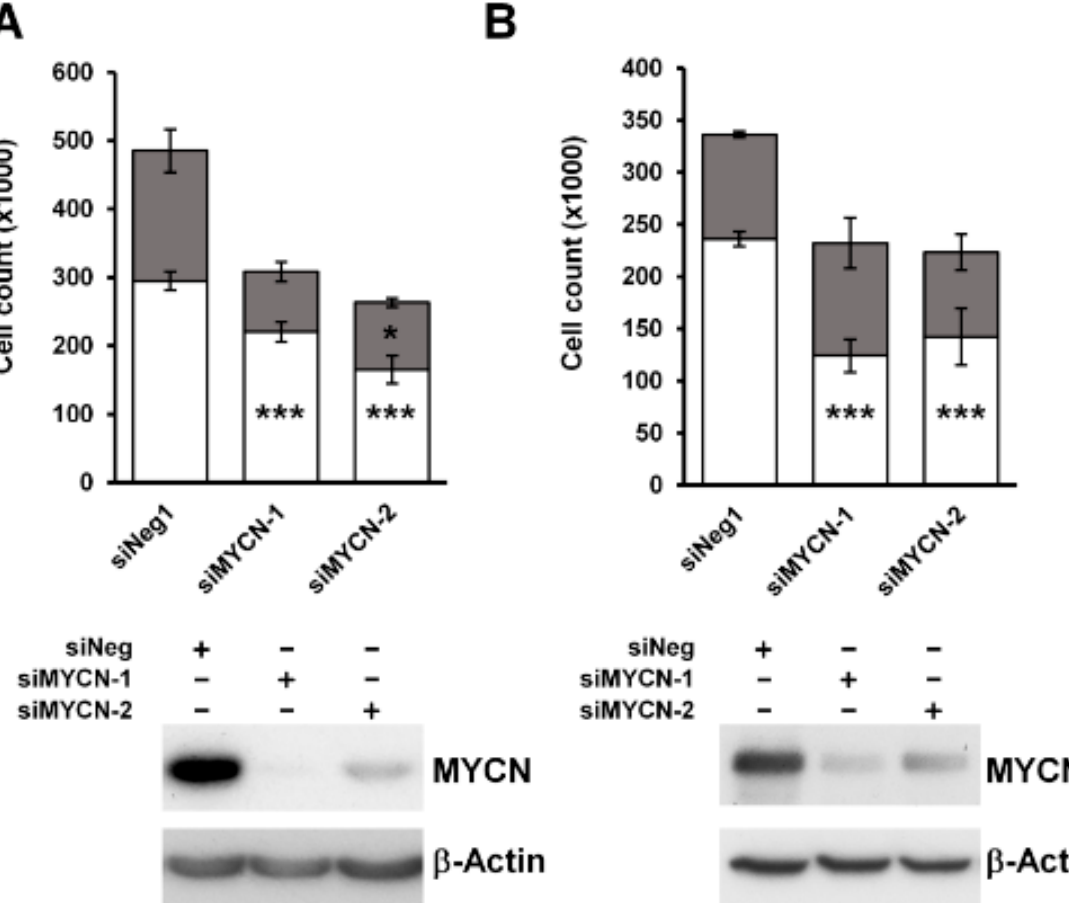
Figure 2. MYCN depletion leads to significant growth inhibition in anaplastic WT cell-lines. ( A ) MYCN depletion resulted in significant growth suppression after 120 h of treatment in Wit49, but not in an increase in dead cells, using two different siRNAs. ( n = 3, *** p < 0.01, * p < 0.05, two-tailed t -tests). Live cell counts are indicated by white bars and dead cell counts are shown in grey. ( B ) MYCN knockdown also led to significant growth suppression in 17.94 cells after 120 h ( n = 3). Western blotting confirmed efficient knockdown of MYCN protein in both cell-lines. * Uncropped Western blots are available in Figure S5A.